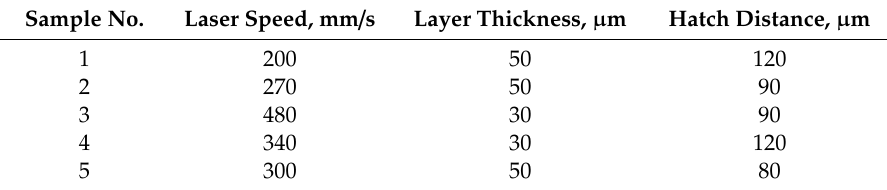
Table 2. Selective laser melting (SLM) process